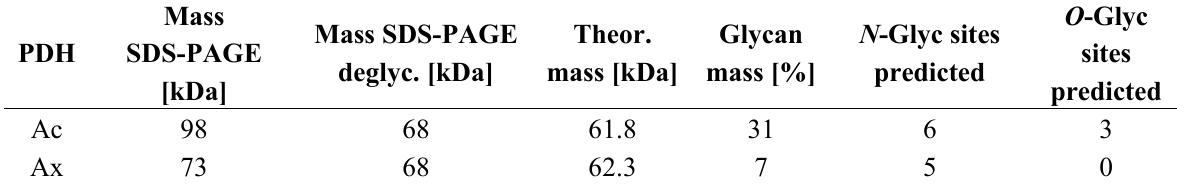
Table 2. Molecular properties of recombinant PDHs.